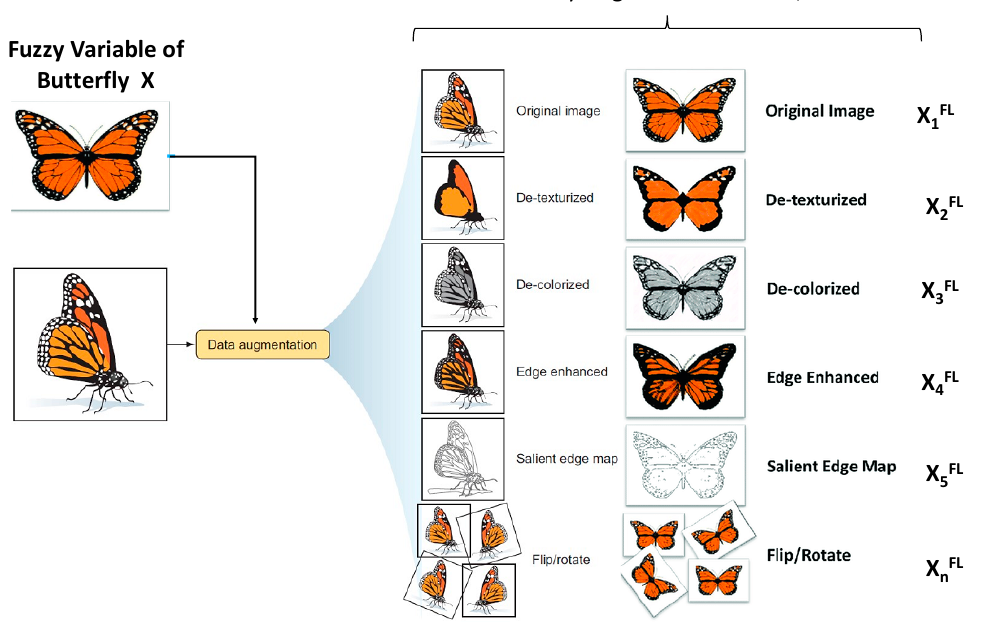
Figure 3. Image data augmentation technique for increasing the size of an image to train a deep neural network algorithm. The drawing has been modified for the purpose of this study. The variables X and X FL are mathematical representations used in this study to mimic the image data augmentation strategy using fuzzy mathematics to design the proposed system. Energies 2020 , 13 , x FOR PEER REVIEW